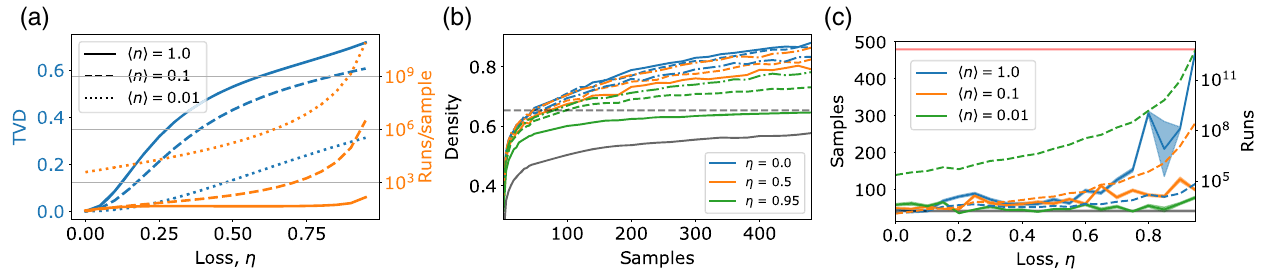
FIG. 7. (a) TVD and runs/samples as a function of the input loss for several mean photon numbers per mode at the output. (b) Density as a function of the number of samples used in the random search algorithm for several mean photon numbers indicated in the legend of (a). The different colors correspond to different input losses in the system while the black curve shows the performance of the algorithm when using uniform random samples. (c) Number of samples (solid lines) and runs (dashed lines) needed to achieve a certain mean density, defined by the black dashed line in (b), as a function of the input loss for several mean photon numbers. The shaded areas correspond to one standard deviation of the mean. The black line indicates the density achieved by the algorithm when using samples drawn directly from the adjacency matrix of the graph and the red line corresponds to uniform drawn samples. The shaded areas correspond to one standard deviation of the